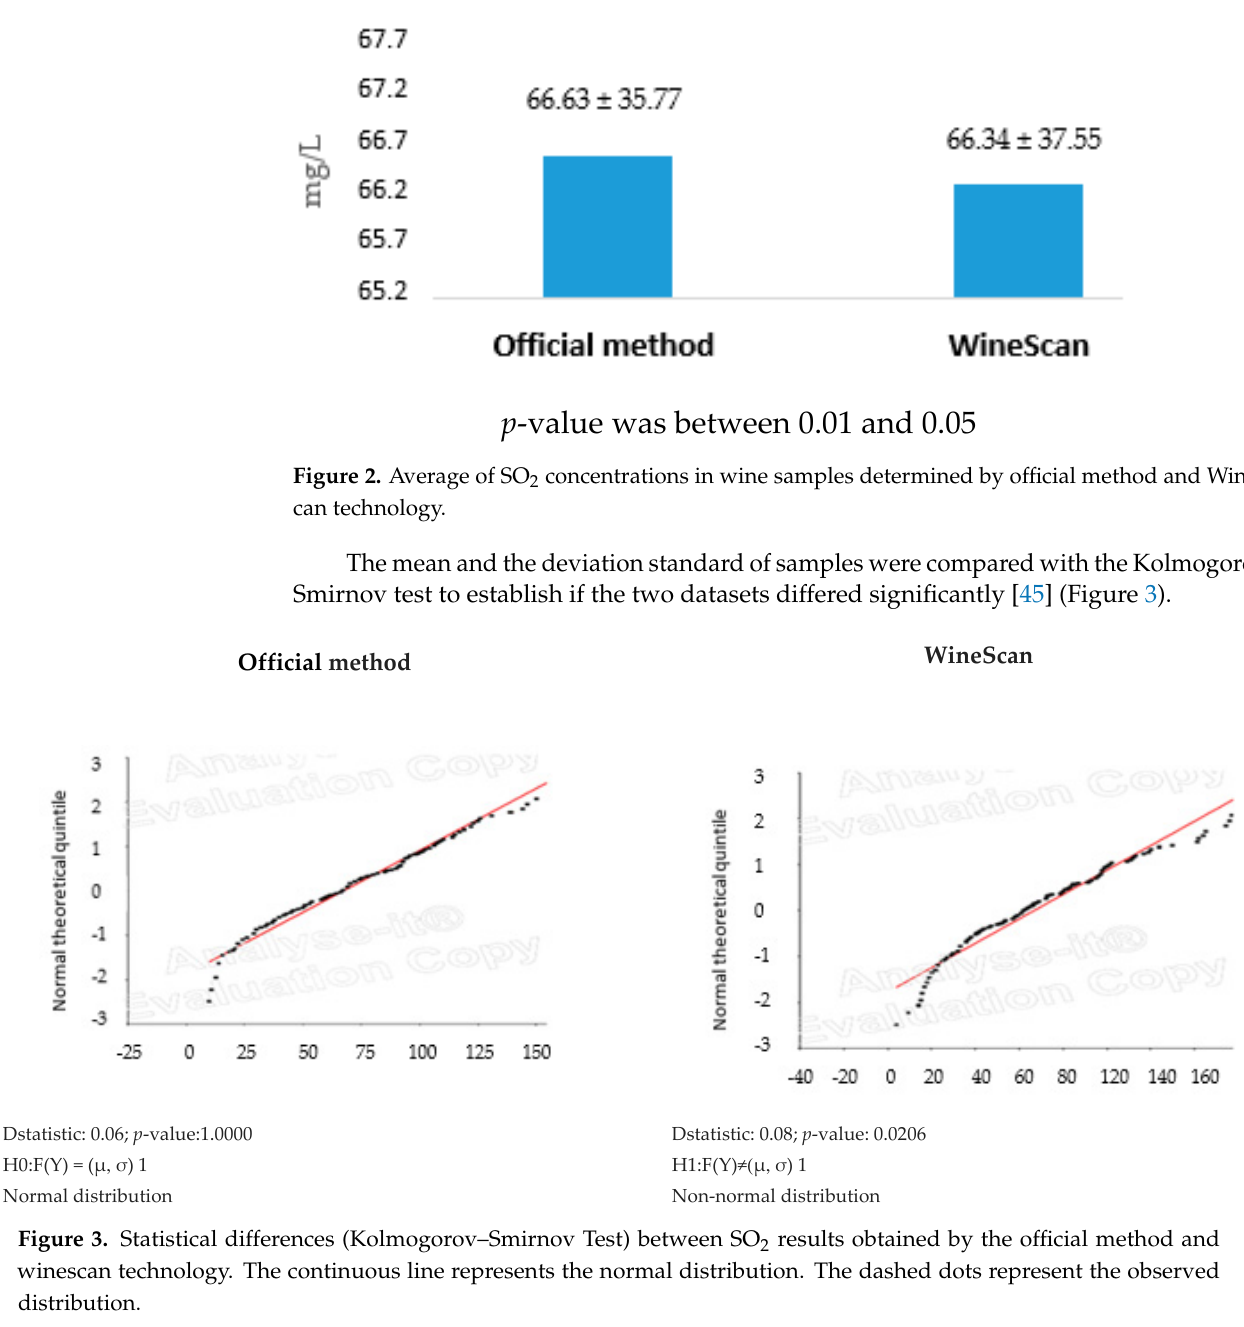
Figure 3. Statistical differences (Kolmogorov–Smirnov Test) between SO 2 results obtained by the official method and winescan technology. The continuous line represents the normal distribution. The dashed dots represent the observed distribution.